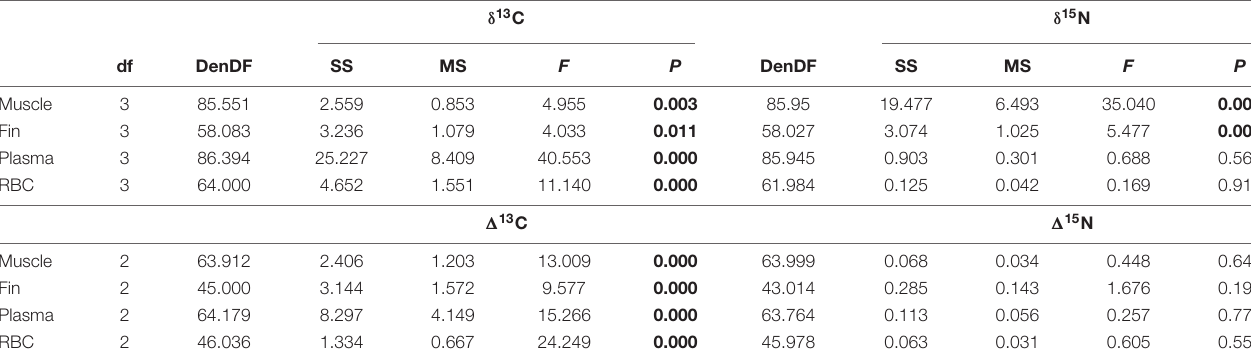
Initial relationships were investigated using linear mixed-effects models with Treatment as a fixed effect and Species as a random effect [Response ∼ Treatment + (1| Species)]. ANOVA F-tests and p-values were calculated using Satterthwaite’s method for denominator degrees-of-freedom and F-statistic. Bold indicates significance at the p < 0.05 level. Df, degrees-of-freedom; DenDF, denominator degrees-of-freedom; SS, sum of squares; MS, mean squares.